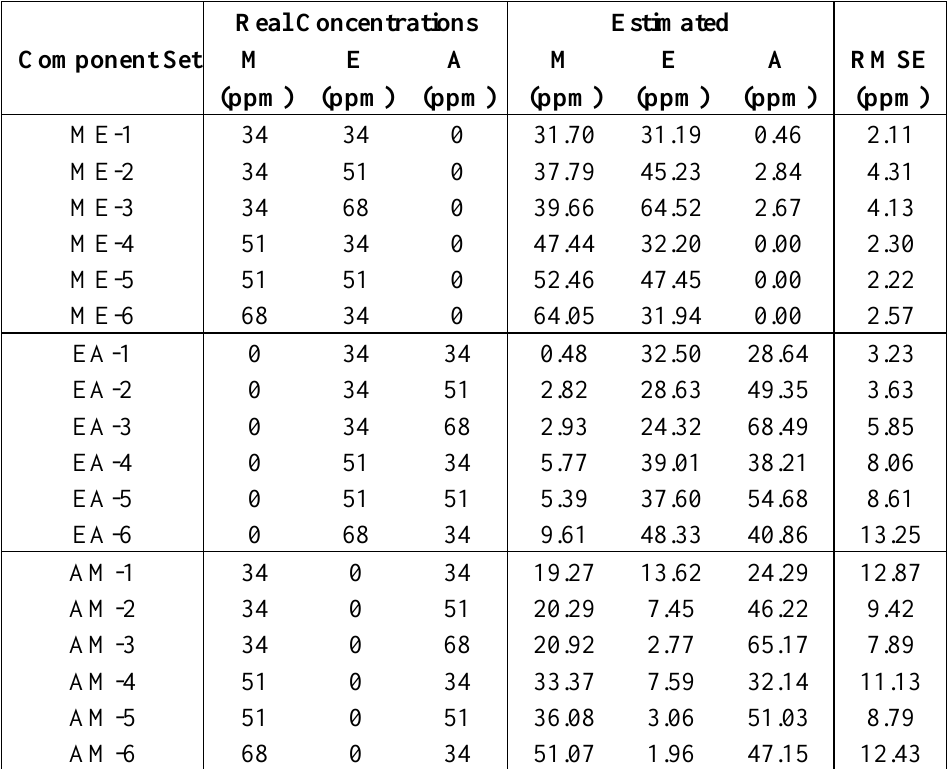
Table 8. The concentration estimation results of the proposed methodology for pure odors.